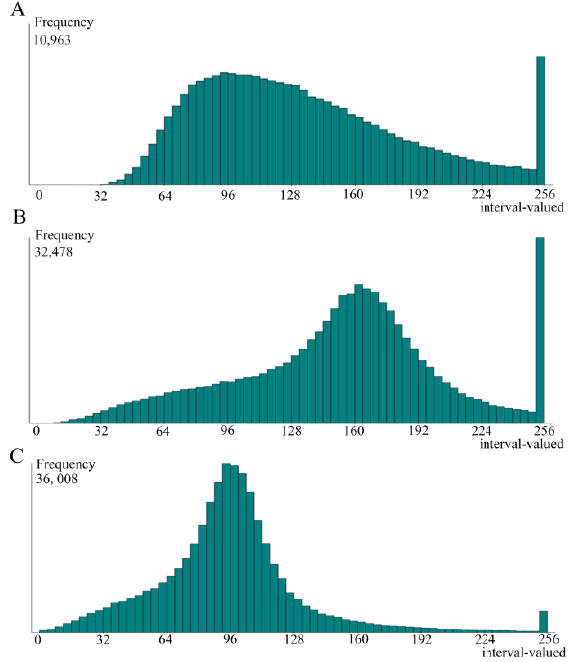
Figure 5. The statistics of lipid droplets size and distribution of different groups. Abscissa stands for average intracellular lipid droplet size in square micrometers ( µ m 2 ). The ordinate represented the frequency of the highest point, and the higher the value, the more times that point occurs. ( A ): control group (0 mmol/L of glucose + 0 mmol/L of betaine); ( B ): 20 mmol/L of glucose + 0 mmol/L of betaine group; ( C ): 20 mmol/L of glucose + 20 mmol/L of betaine combined treatment group.